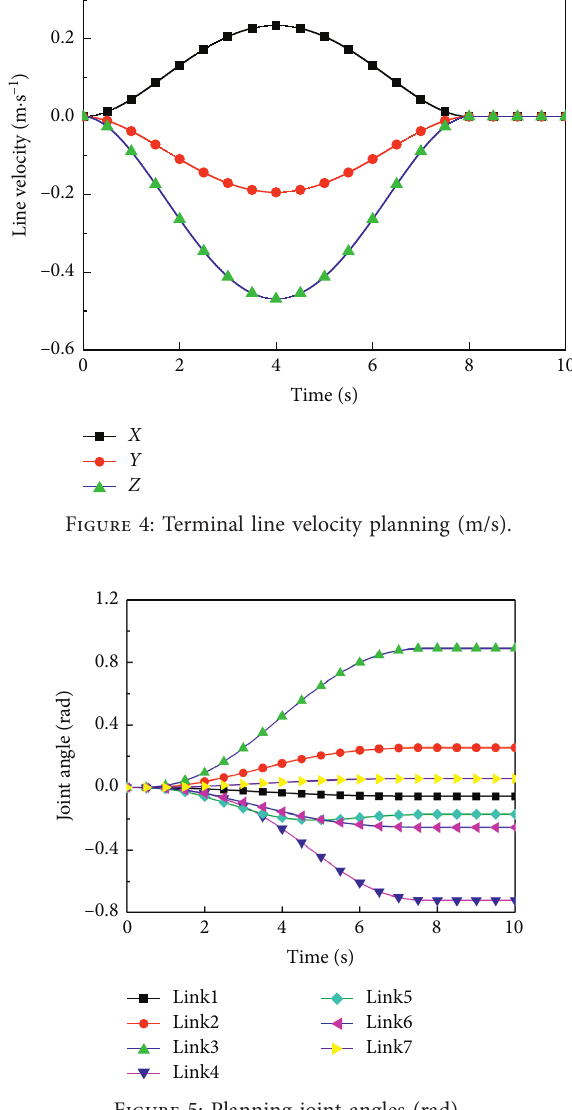
Figure 7: Plan for joint angular acceleration (rad/s − 2